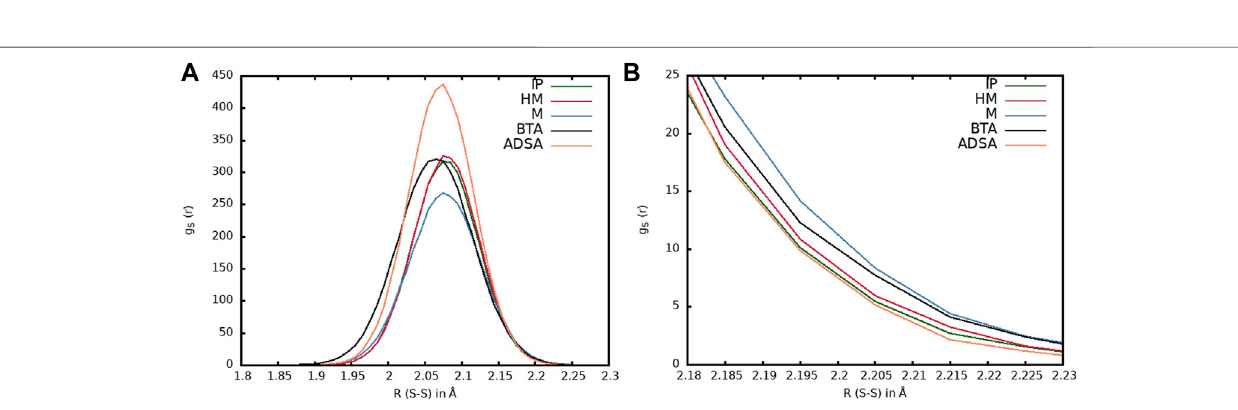
Frontiers in Materials |